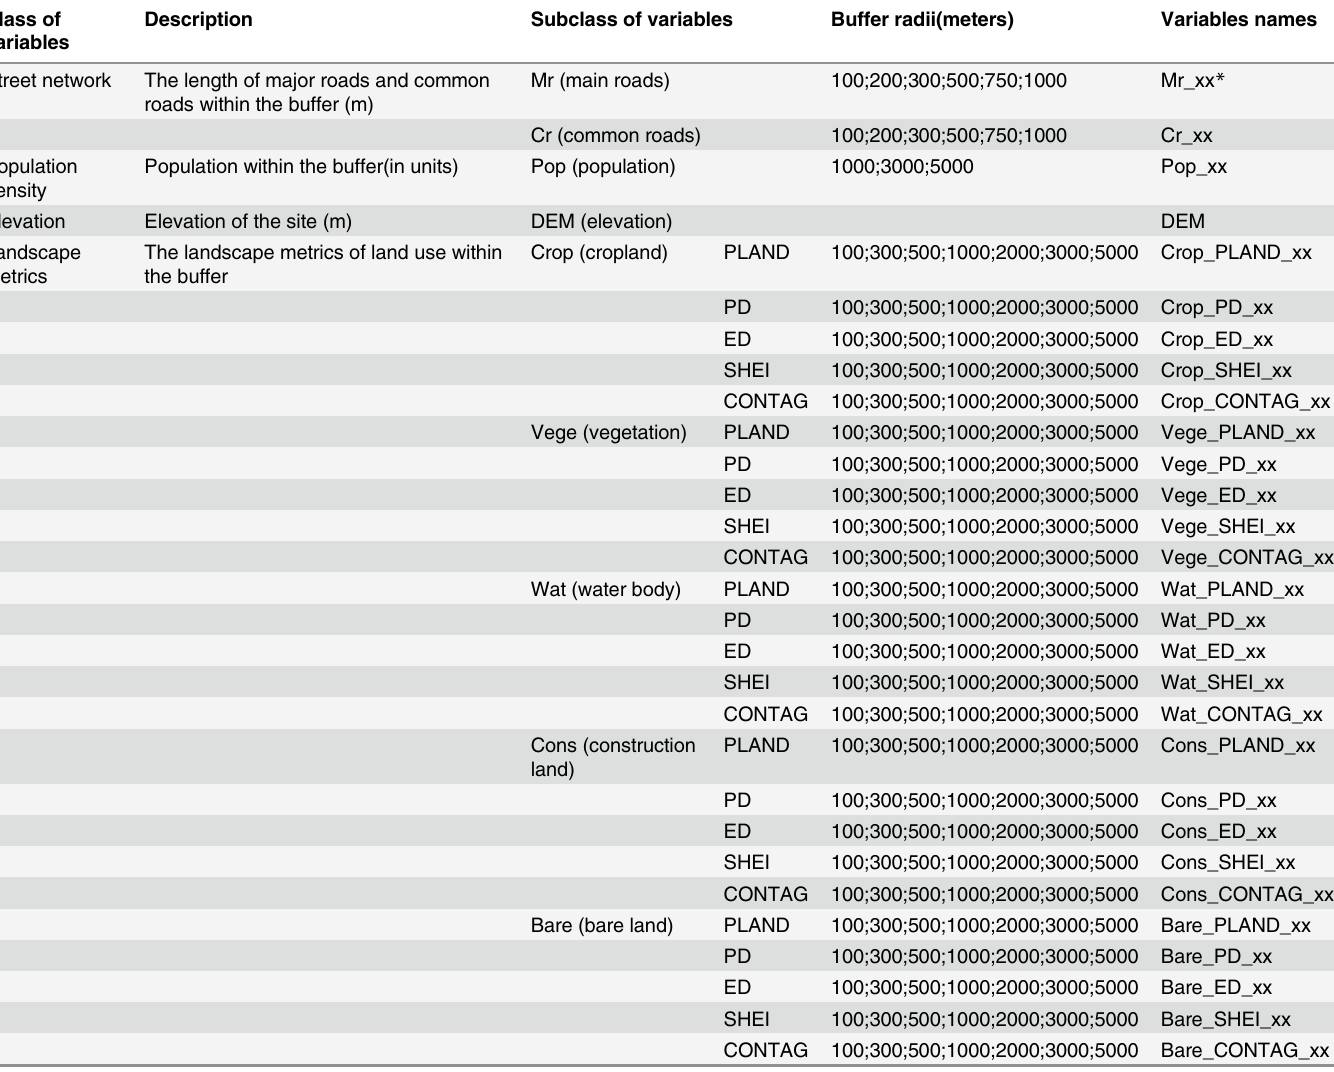
Table 2. Classification and description of independent